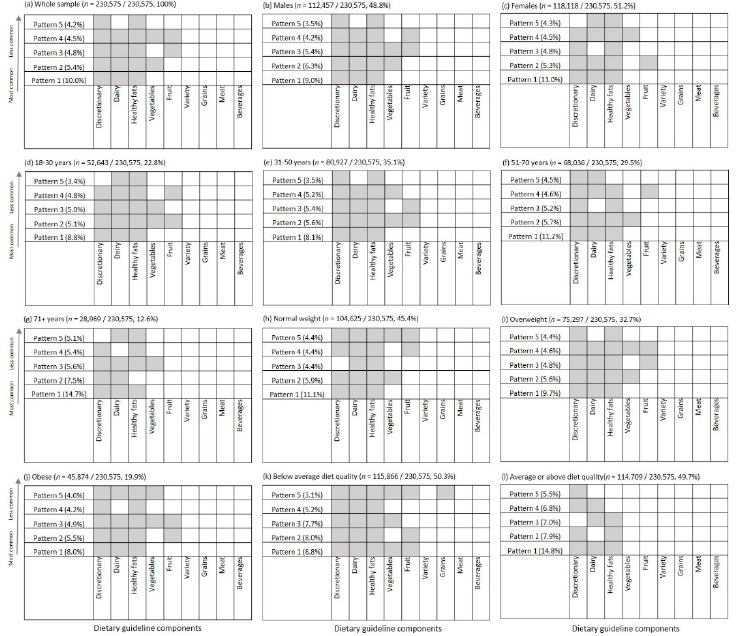
Figure 4. The five most common combinations of low scoring diet guideline index components, by gender, age group, weight status and diet quality. Data not shown for underweight individuals n = 4779/230,575, 2.1% of the sample).